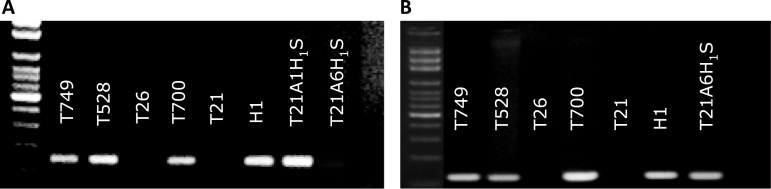
PCR amplification products using (A) primer pairs designed in the AK362725 gene from H. vulgare that amplifies specifically the 1HchS chromosome in H. chilense and does not produce an amplification product in wheat; (B) SSR marker Bmac 316 that amplifies specifically the 6HchS chromosome in H. chilense. T749, T21-H. chilense disomic addition of Hchac in H1 cytoplasm; T528, T26-H. chilense disomic addition of Hchac in H1 cytoplasm; T26, T. aestivum carrying the translocation T1RS·1BL; T700, T21-H. chilense monosomic addition of Hchac in H1 cytoplasm; T21, T. aestivum cv. Chinese Spring; H1, H. chilense accession H1; T21A1H1S, T21 ditelosomic addition of 1HchS; and T21A6H1S, T21 ditelosomic addition of 6HchS.